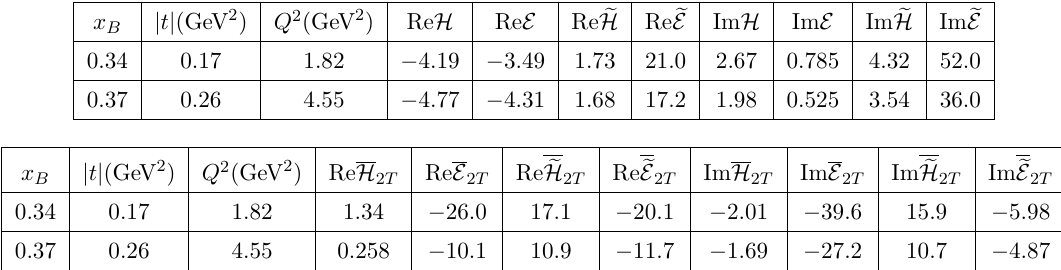
Table 1 . Twist-two and twist-three CFFs used for numerical comparison. The values are obtained using GPDs calculated in a spectator model and perturbatively evolved to the scale of the chosen Q 2 [72,